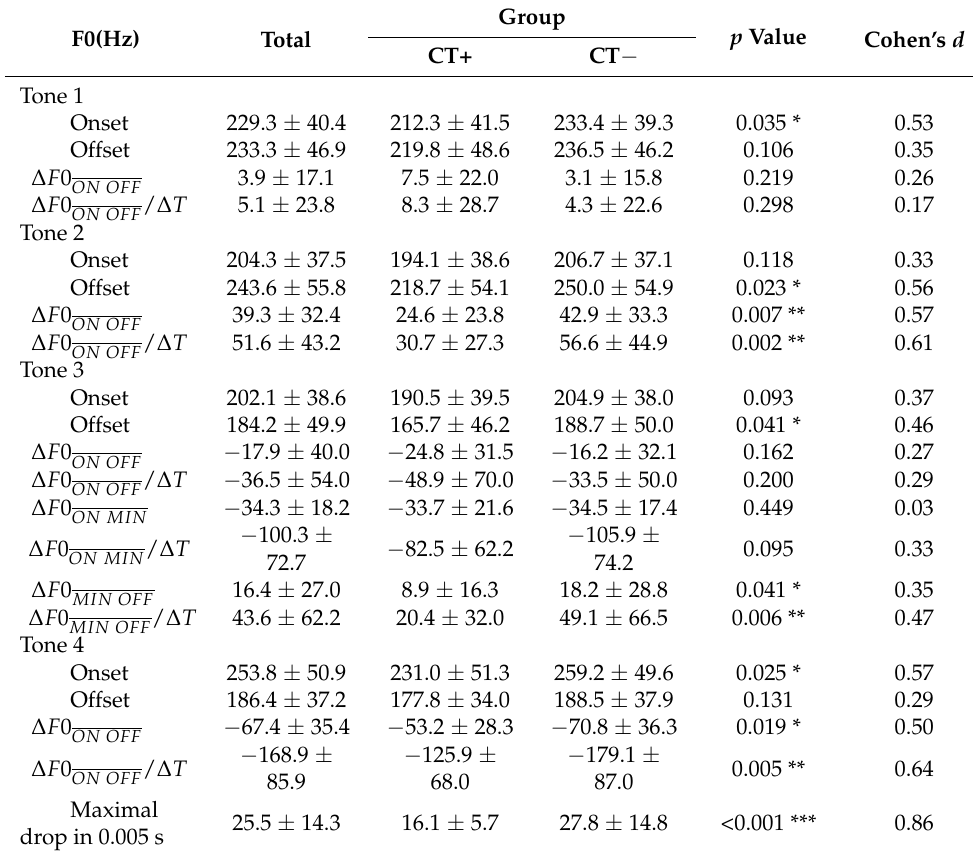
Table 2. Comparison of fundamental frequency (F0) between the CT+ and CT − groups when producing the four tones.